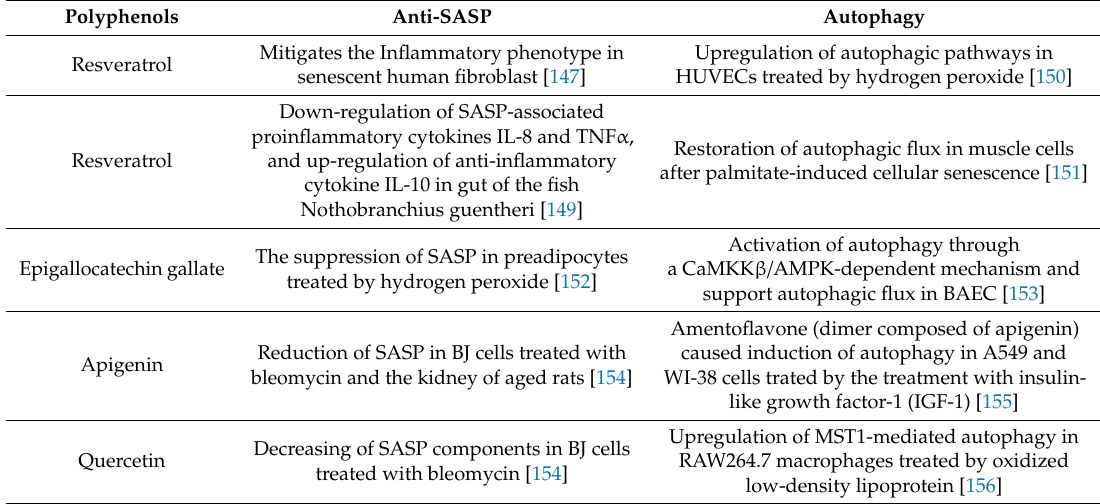
Table 1. Regulation of senescence-associated secretory phenotype (SASP) and autophagy by